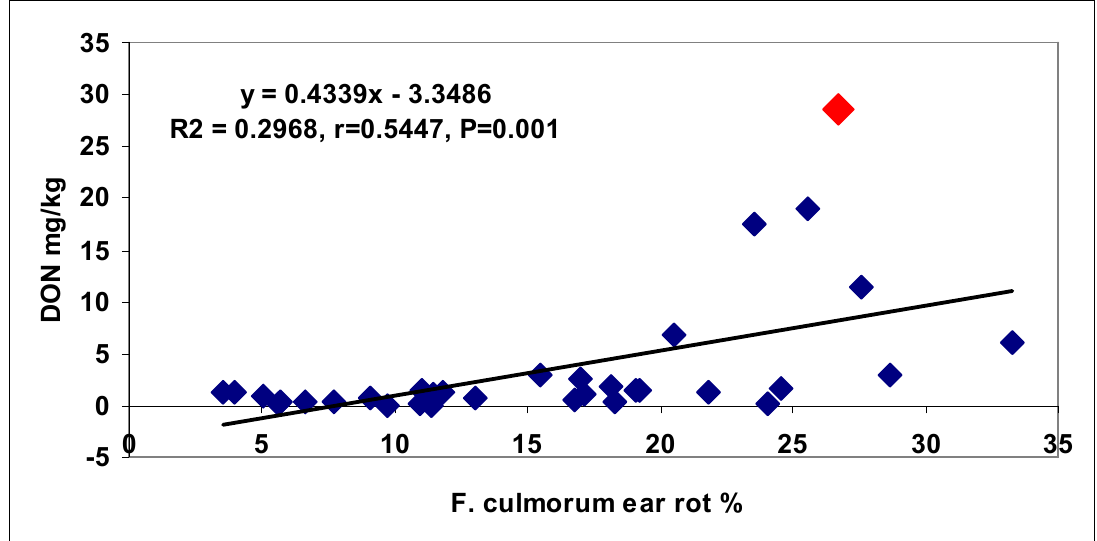
Figure 7. Regression between Fusarium culmorum ear rot severity (%) following toothpick inoculation and DON contamination ( n = 34), Szeged, 2010–2011, n = 34. LSD 5% DON = 11.65, red highlighted genotype SBL19: Difference between 28.60 and calculated DON by the linear function (8.26) is 20.34 that is higher than LSD 5% 11.65, therefore DON overproduction is proven. Statistical method: Built-in Excel function for regression calculation.